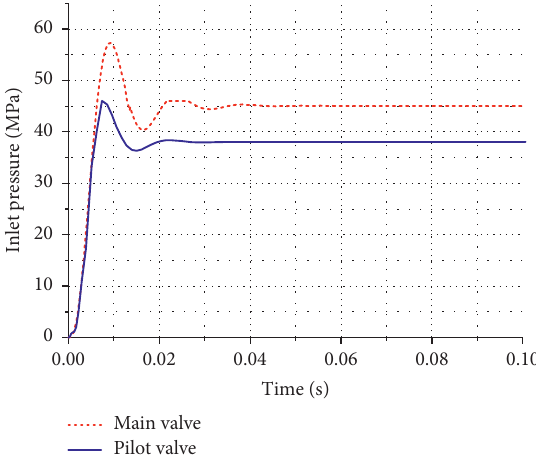
Figure 21: Dynamic response curves of pilot valve and main valve.